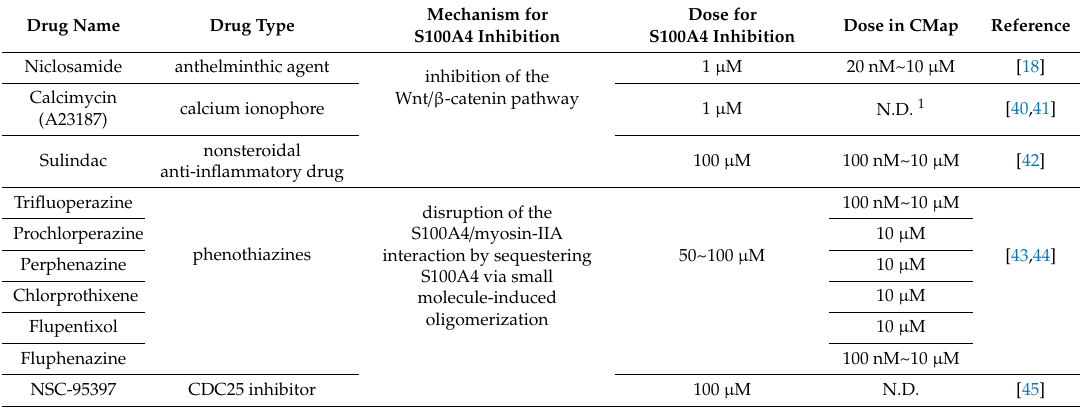
Table 4. A list of reported S100 calcium-binding protein A4 (S100A4)